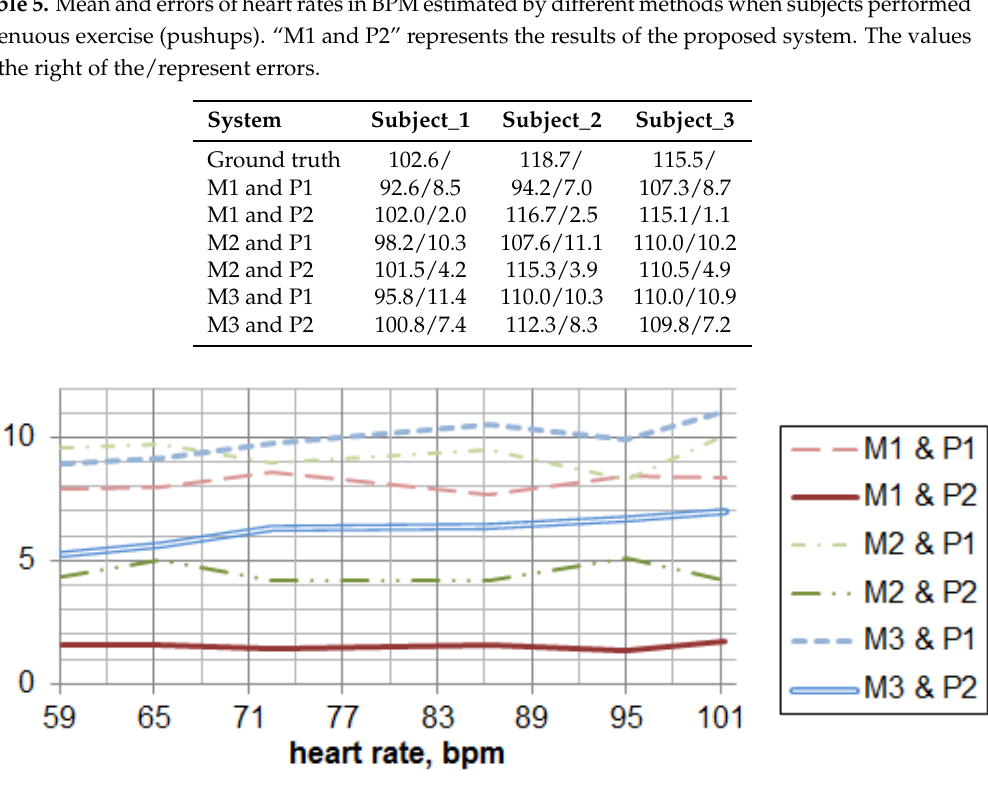
Figure 10. Relationship between mean errors in BPM of different heart-rate estimation methods and heart-rate magnitude. “M1 and P2” represents the results of the proposed